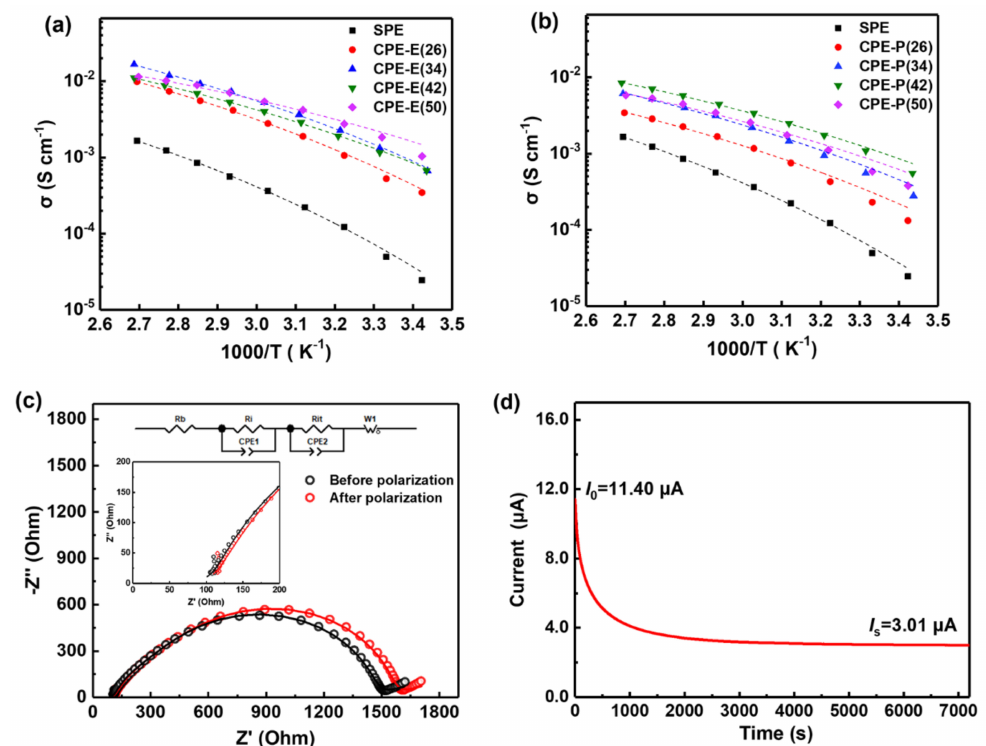
Figure 3. Temperature dependence of ionic conductivity for SPE and different CPEs ( a , b ). Nyquist plots before and after polarization ( c ) and the polarization curve ( d ) of the Li|CPE-P(34)|Li cell with a potential step of 20 mV at 20 ◦